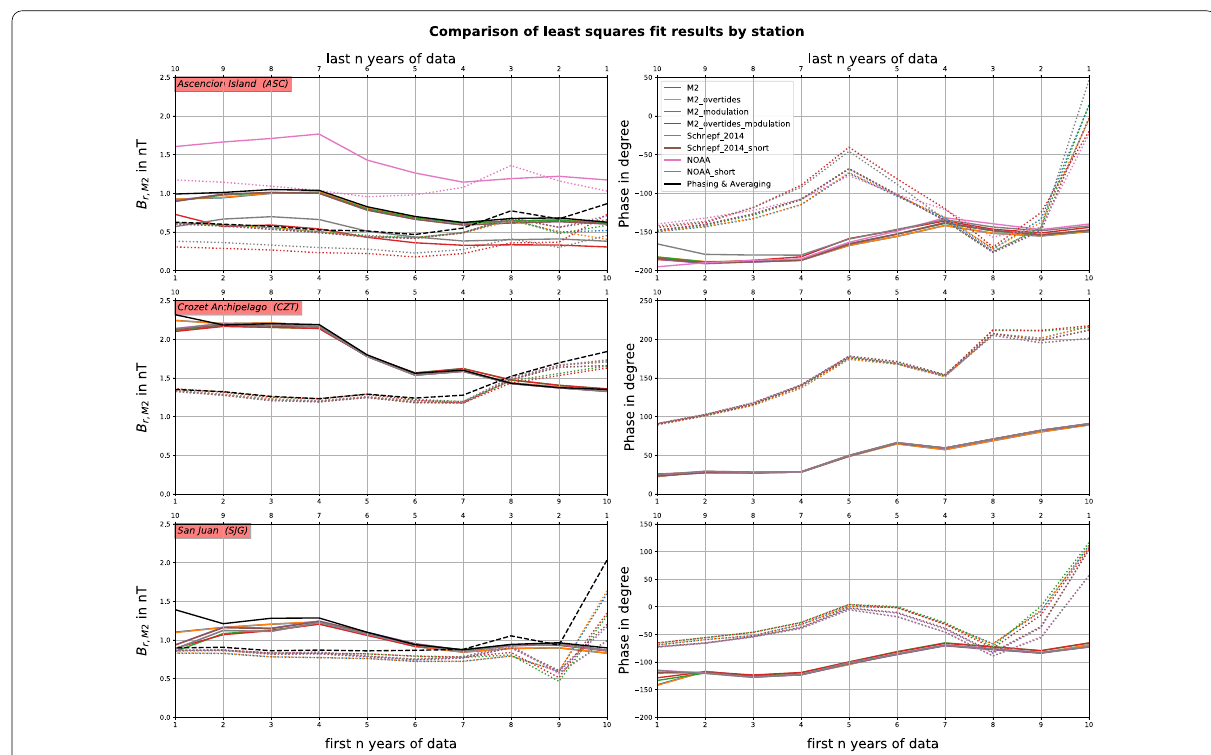
Fig. 4 Comparison of oceanic M2 tide induced magnetic field signal parameters extracted from the residual data with least squares fitting of different harmonic sums. The left column shows the extracted amplitudes and the right column the extracted phases in dependence of analysed time series length. While solid lines show the results for the analysis conducted on the first n years of the 10 year time series (corresponding to lower x‑axis), dotted lines show the analysis results for the last n years of data (corresponding to upper x‑axis). Black lines in the left column show the results obtained by phasing and averaging the residual data and allows for a comparison of both methods. Please note, on the right‑hand column the y‑scales vary by row. This choice was made to increase presentability of the obtained results. Root mean square values of the residual data for each data point, i.e., for each the fit made with each fit function to the given time span is summarized in the Additional file 1 under Tables